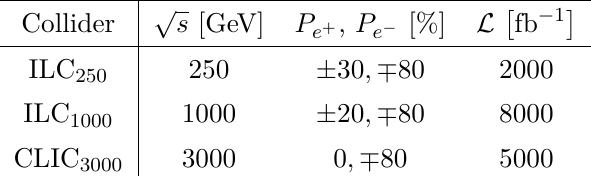
Table 3. Summary of the main configuration settings for the future linear e + e − colliders considered in our study (see text for details). The first column corresponds to the collider, the second column √ s , in GeV, the third column corresponds to the polarisation P shows the centre-of-mass energy, P of the e + e − beams, and the last column shows the total integrated luminosity, L , in fb − 1 . e −